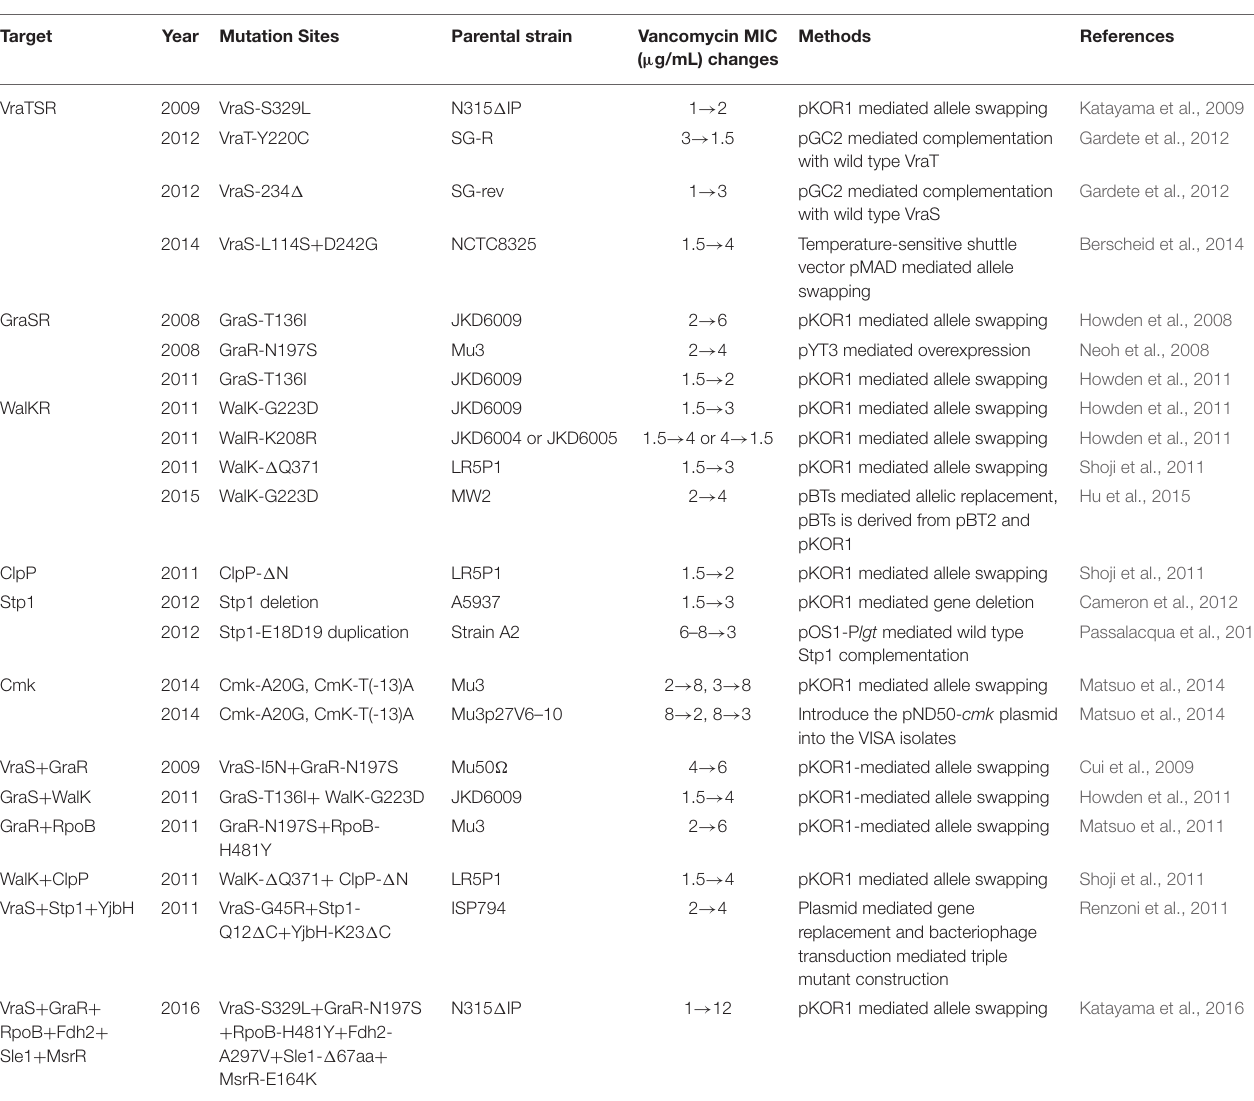
TABLE 2 | Experimental verified mutations in